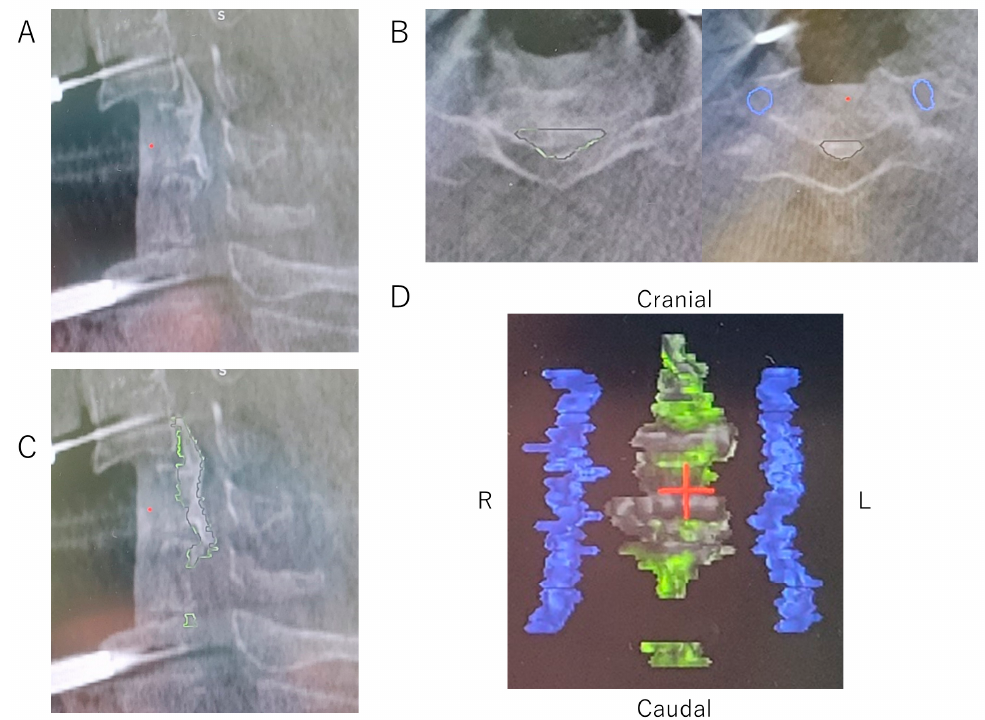
Figure 2. Intraoperative CT images of the OPLL. ( A ) Intraoperative CT sagittal view of the OPLL. ( B ) Outline of ossification (yellow-green line) and blood vessels (blue line) marked on the monitor of the CT axial views. ( C ) Sagittal image of the OPLL, which was reconstructed after marking the outlines of ossification for each axial slice from the cranial end to the caudal end of the OPLL. ( D ) Reconstructed 3D images of the OPLL and bilateral vertebral arteries. CT, computed tomography; OPLL, ossification of the posterior longitudinal ligament.